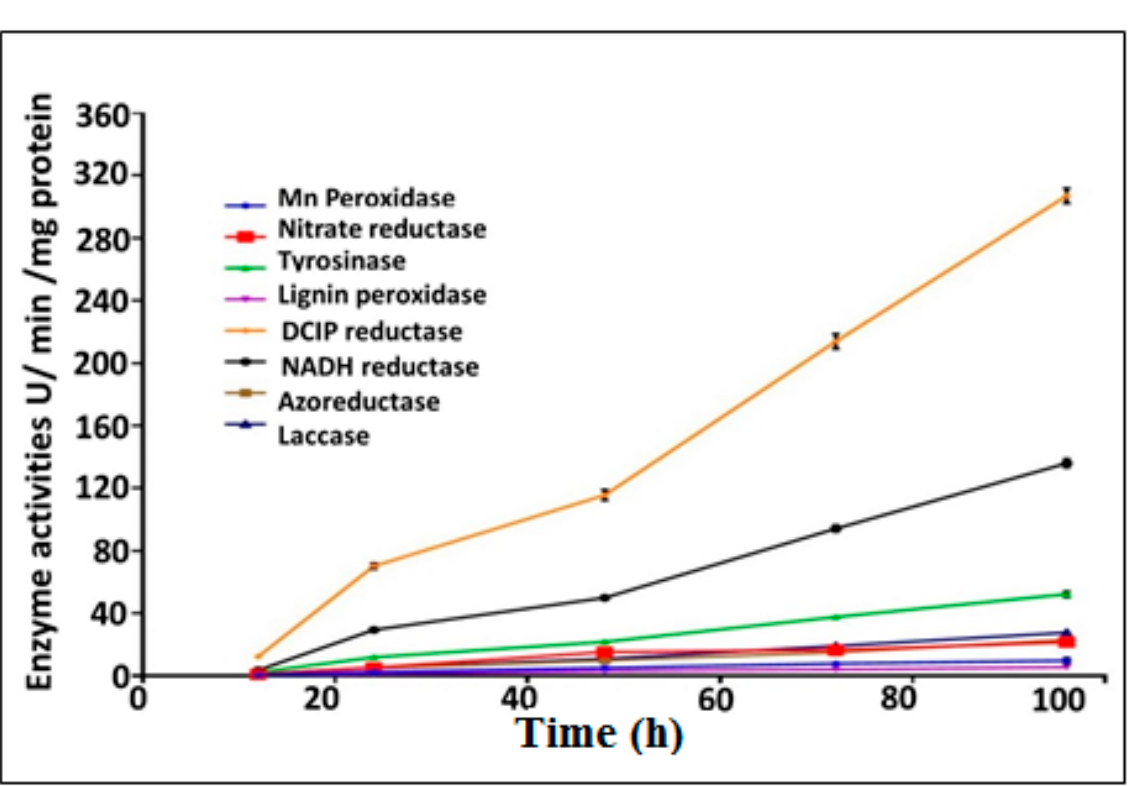
Figure 5. Quantitative bio-induction of eight different degrading enzymes during the decolorization of MO dye by immobilized consortium.